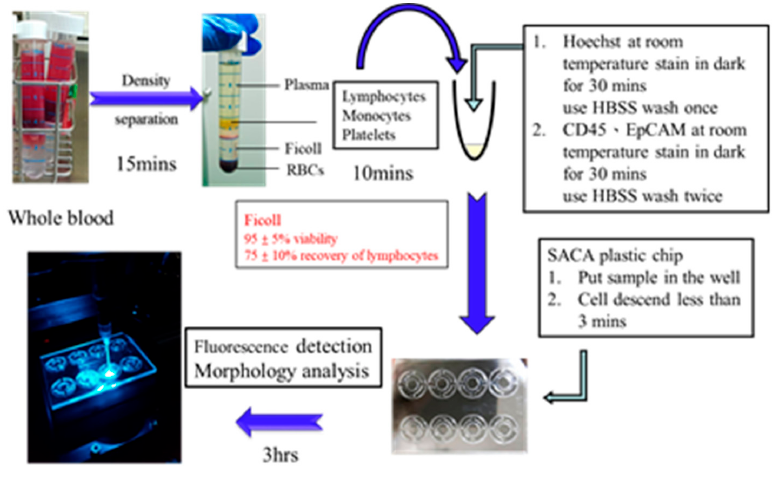
Figure 6. Sample preparation process for clinical trial.